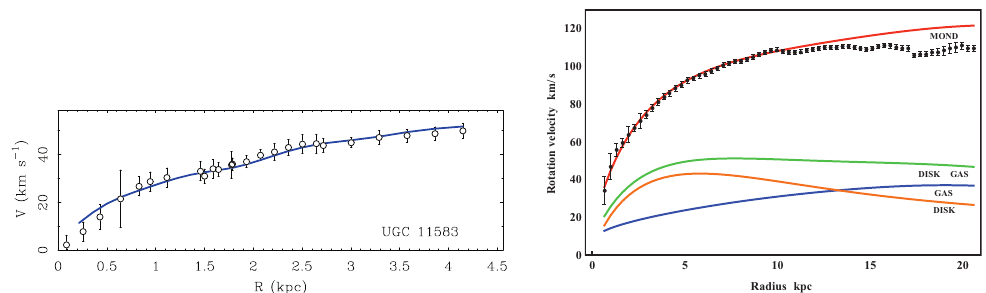
Figure 12. Left panel: Example of MOND fit (blue lines) to a dwarf galaxy (UGC11583, reproduced from [359], Figure 25). Right panel: RC comparison between observed ESO138-G014 (black dots with error-bars) and MOND prediction (red line) (reproduced from